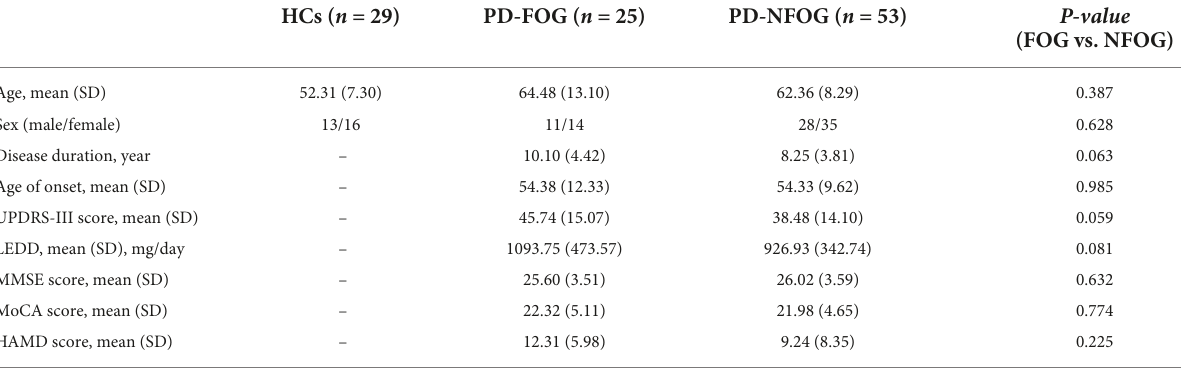
TABLE 1 Demographic and clinical characteristics of HCs and PD patients with and without